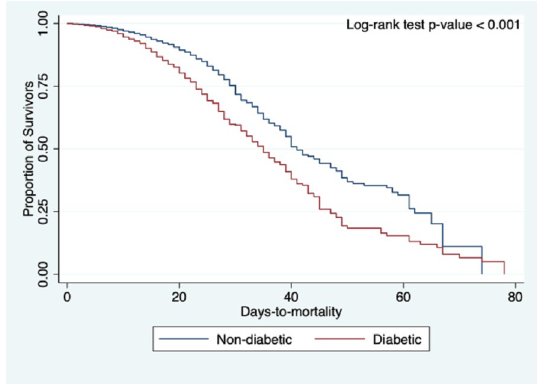
Figure 1. Comparison of Kaplan–Meier curves of in-hospital mortality between COVID-19 patients with diabetes versus non-diabetics, adjusted for the different confounding variables of interest.